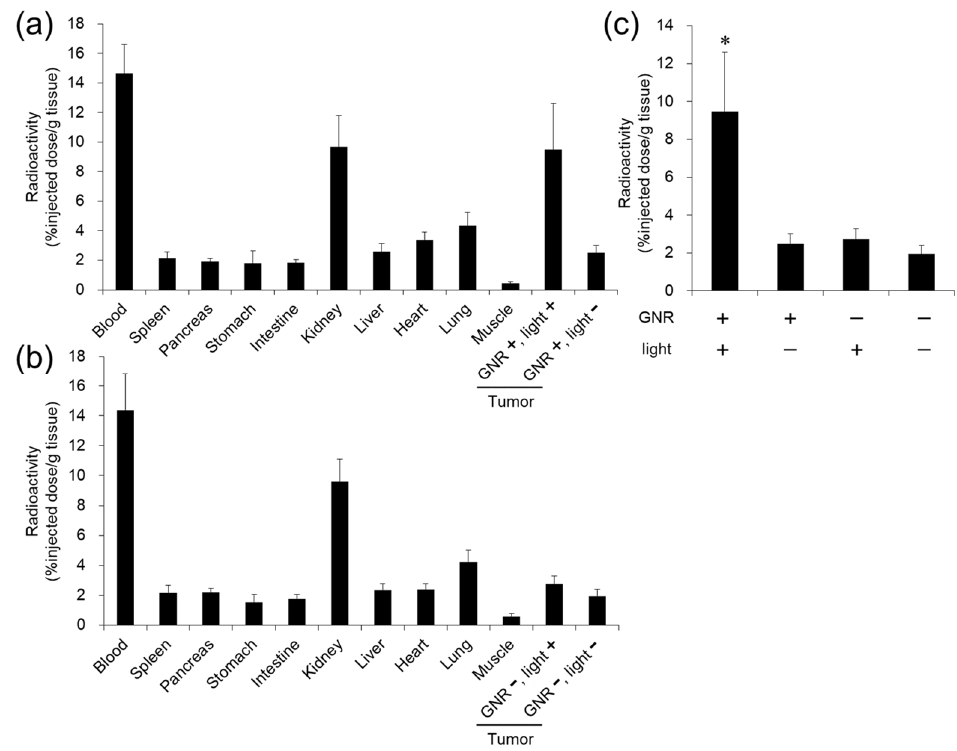
Figure 5. Biodistribution of 111 In-labeled polyoxazoline (POZ) by combination with hyperthermia using gold nanorods (GNRs) irradiated by near-infrared (NIR) light. ( a ) GNR was injected into both tumors inoculated in right and left flanks, and then NIR light was irradiated into the one side of tumors. ( b ) Phosphate-buffered saline (PBS) was injected into both tumors in right and left flanks, and then NIR light irradiated a tumor on one side. ( c ) Radioactivity accumulation in the tumor treated with or without GNR injection and NIR light irradiation. * p < 0.001 vs. other groups.